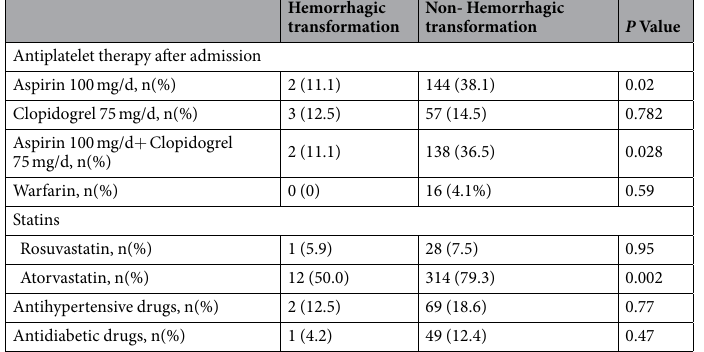
Table 2. Pharmacological treatments during hospitalization treatments.